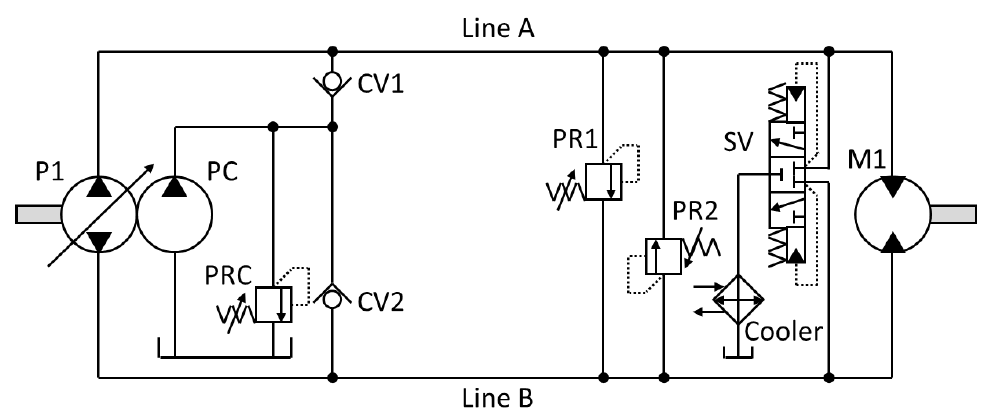
Figure 1. Typical Closed Loop Hydrostatic Transmission Circuit.